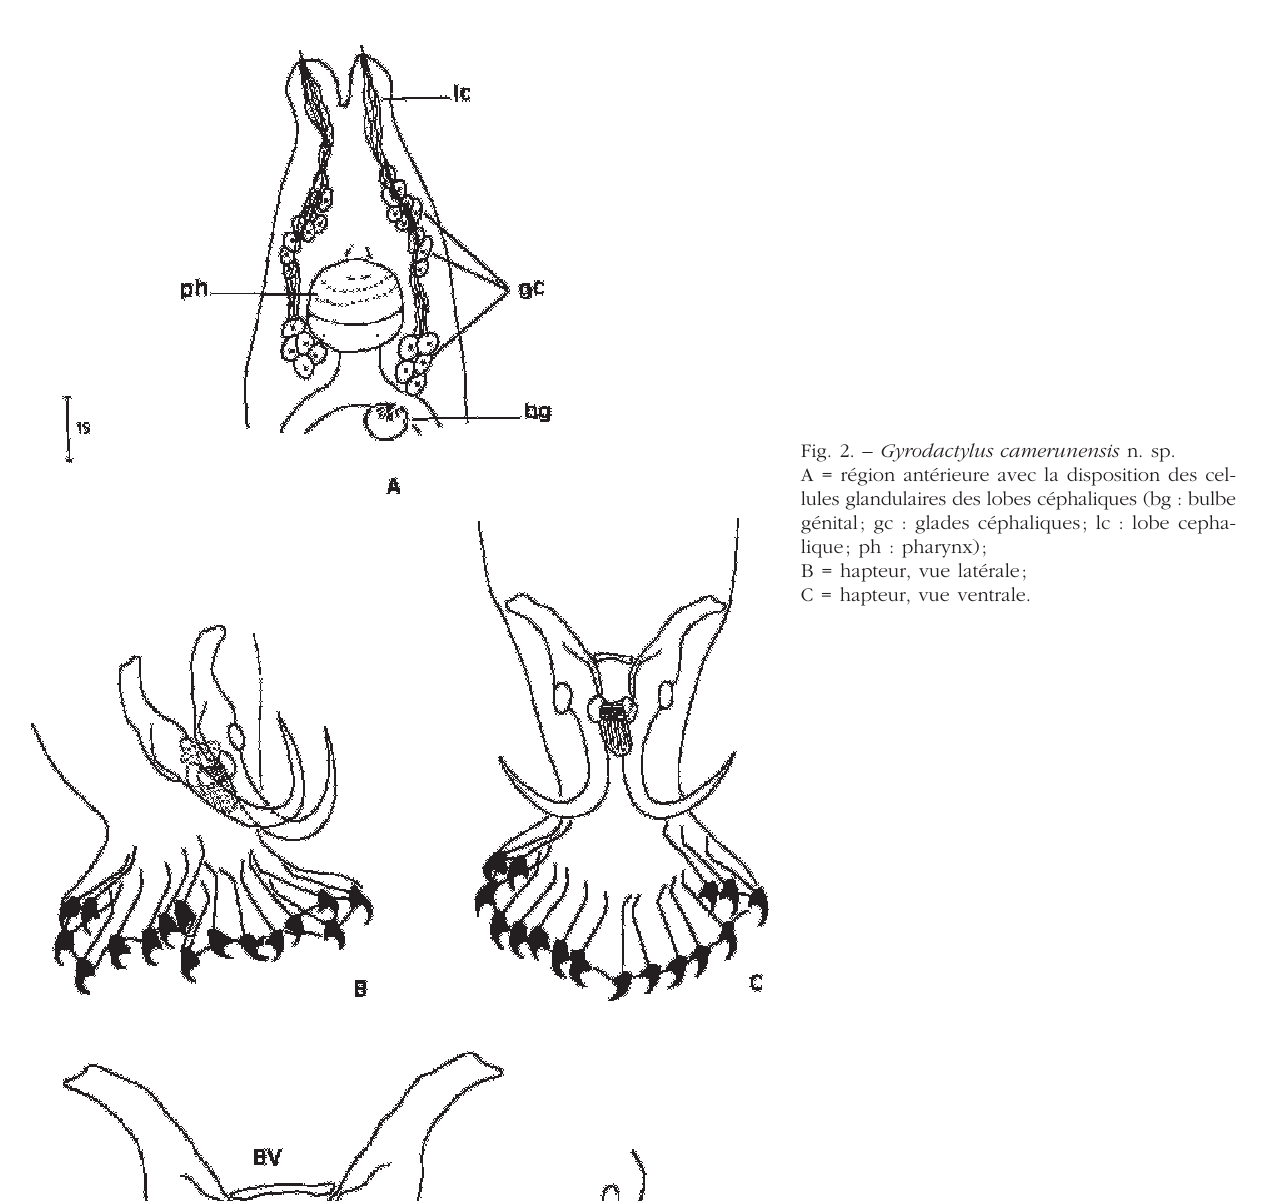
Fig. 3. – Gyrodactylus camerunensis n. sp. BD = barre dorsale; BV = barre ventrale; C = crochet; U = uncinulus; BG = bulbe